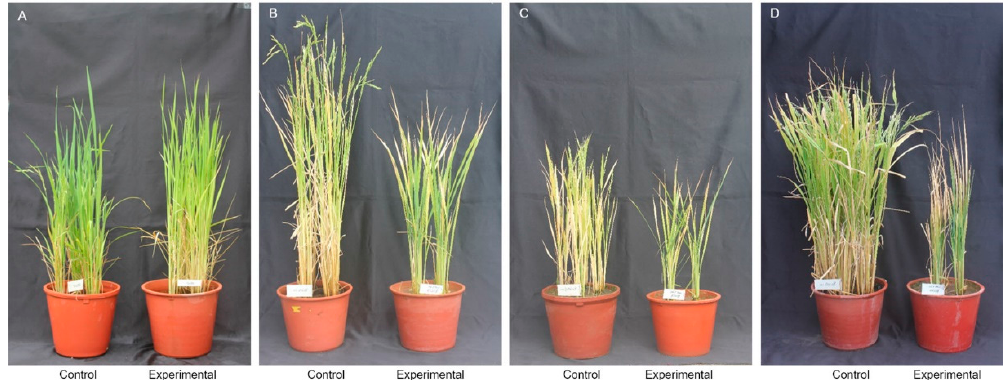
Figure 1. Comparison of phenotypes after high-temperature treatment in rice at the booting stage. The Cheongcheong/Nagdong double haploid (CNDH) 120 line was treated with a high temperature during the booting stage. The phenotype that appeared after the booting stage was assessed. ( A ) Nagdong is a variety that is tolerant to high temperatures; ( B) Cheongcheong is a variety that is susceptible to high temperatures. Culm length decreased and no heading was observed; ( C ) CNDH11 exhibited a decrease in tiller number after the high-temperature treatment and did not show heading; ( D ) CNDH109 exhibited a great decrease in tiller number after treatment with high temperature.